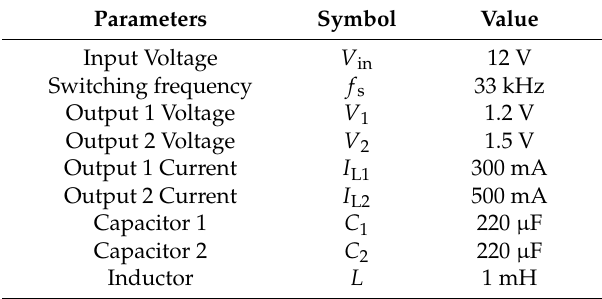
Table 1. Specifications for SIDO converter.